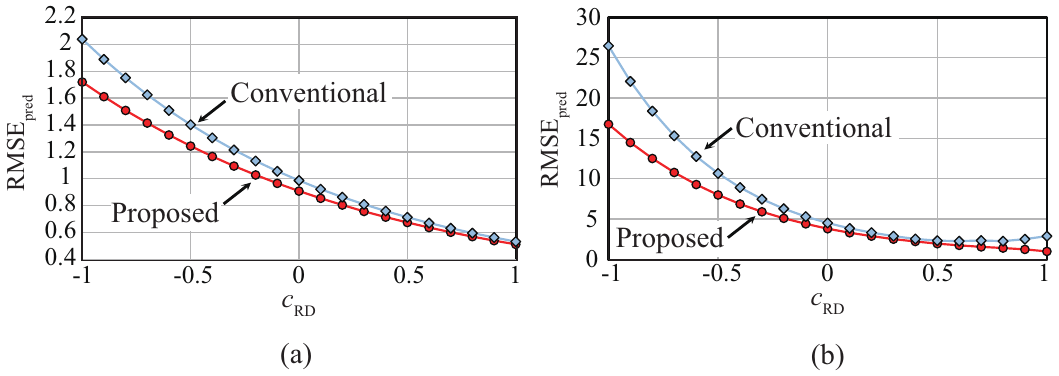
Figure 2. Relationship between c RD and RMSE pred for Γ D = 0.1 ( a ) and 1 ( b